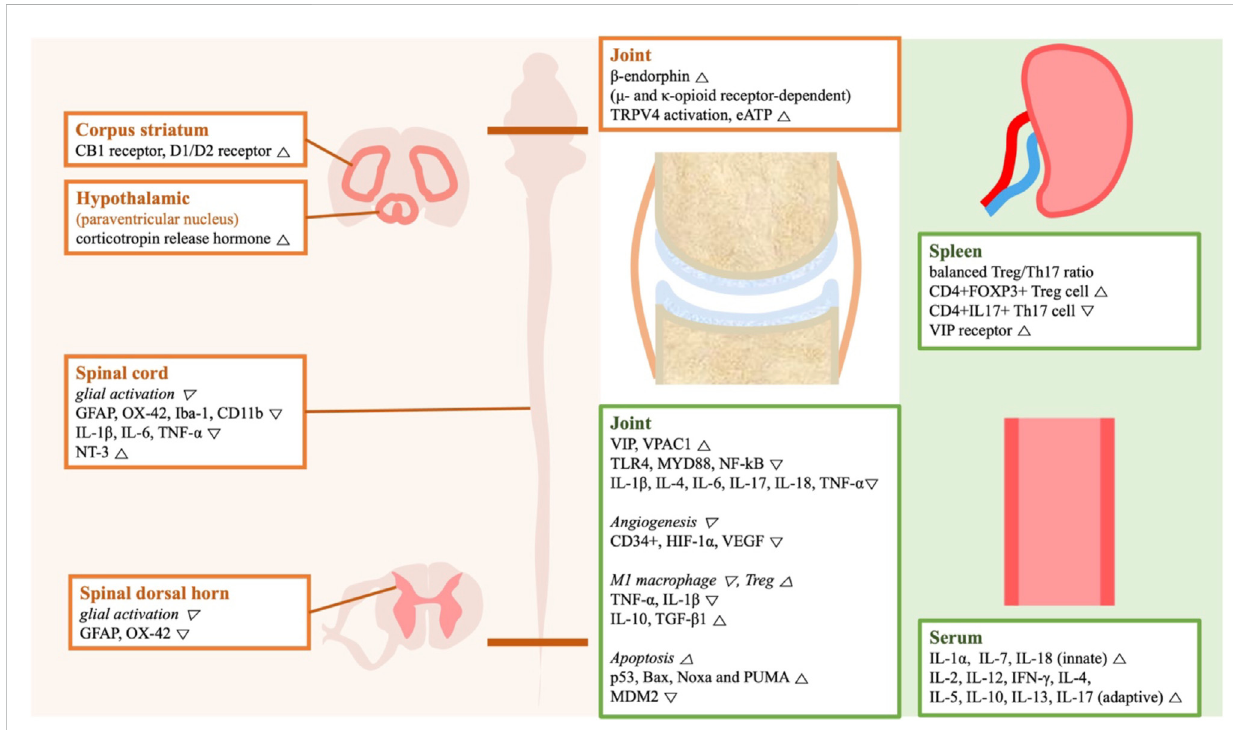
A schematic illustration of the genes and the signaling molecules regulated by acupuncture treatment in the included animal studies. The gene expression listed in orange boxes is related to acupuncture (left), while those in green boxes are related to acupuncture-mediated anti-in fl